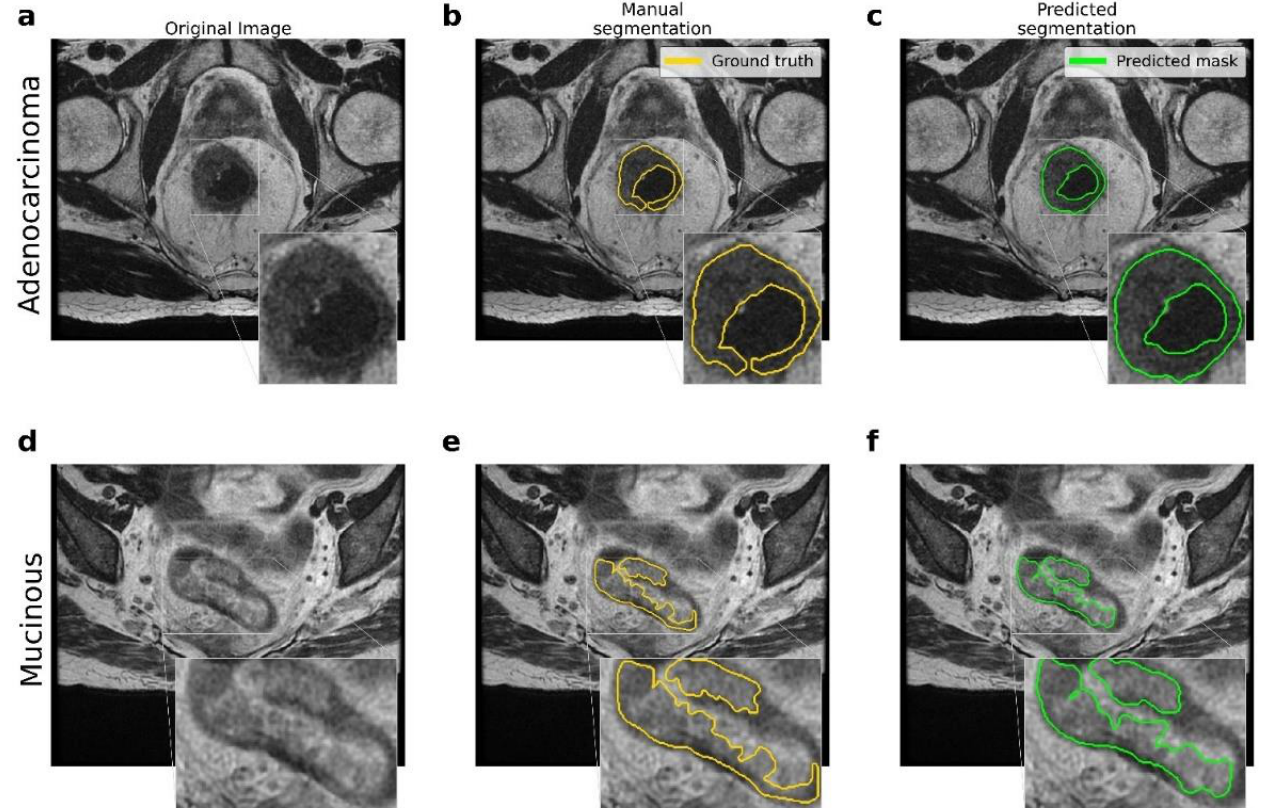
Figure 2. Comparison between the ground truth and the results obtained by the proposed pipeline for the lesion segmentation. ( a – d ) Original MRI scans for adenocarcinoma and mucinous cases. ( b – e ) Ground truth obtained by manual segmentation performed by experts. ( c – f ) Predicted segmentation obtained by the proposed U-Net model.